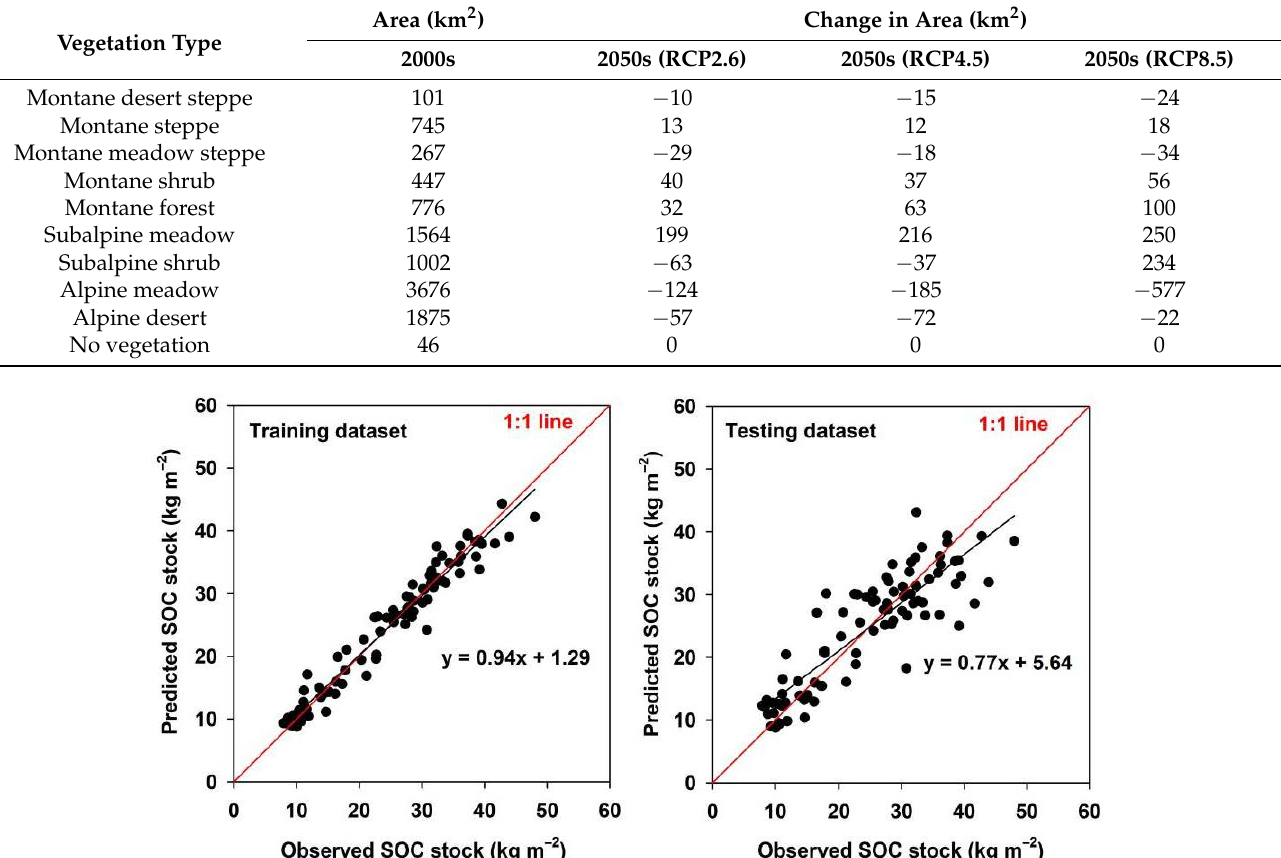
Figure 8. Comparison between predicted and observed values for the SOC stock at 0–60 cm. Note: the predicted SOC stock in the scatter plots are averages of the predictions from 100 runs of the ten-fold cross-validation procedure. Table 2. Evaluation of the performance of random forest model in predicting SOC stock.